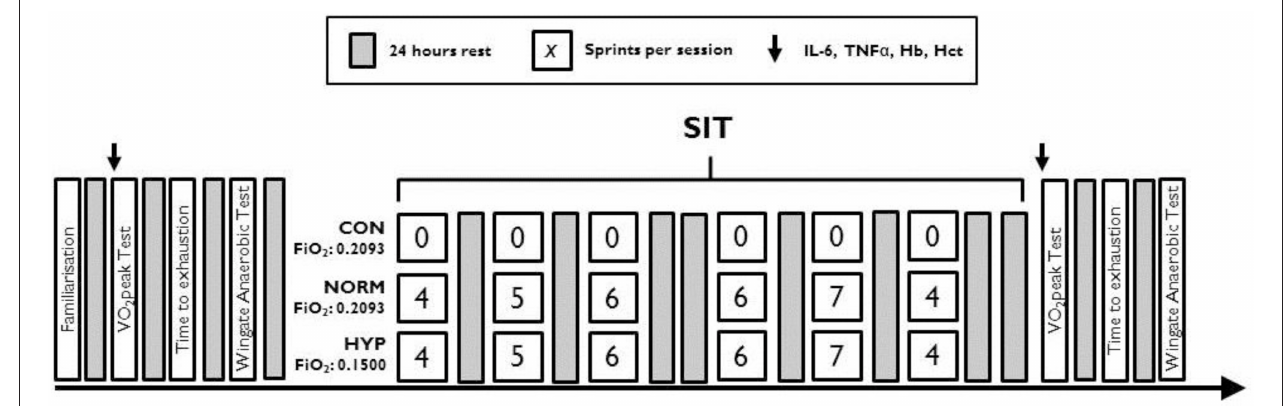
FIGURE 1 | Schematic of the testing and sprint interval training protocol for each training group.